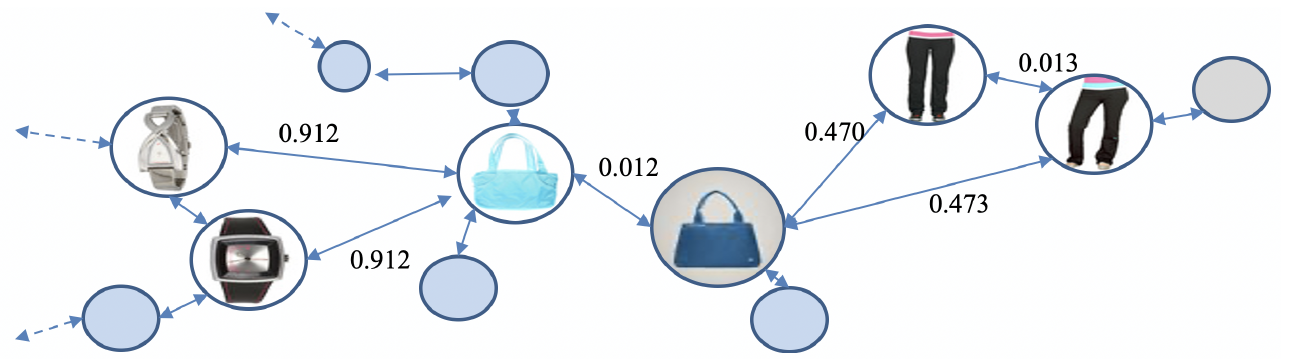
Figure 3. Graphical representation of image